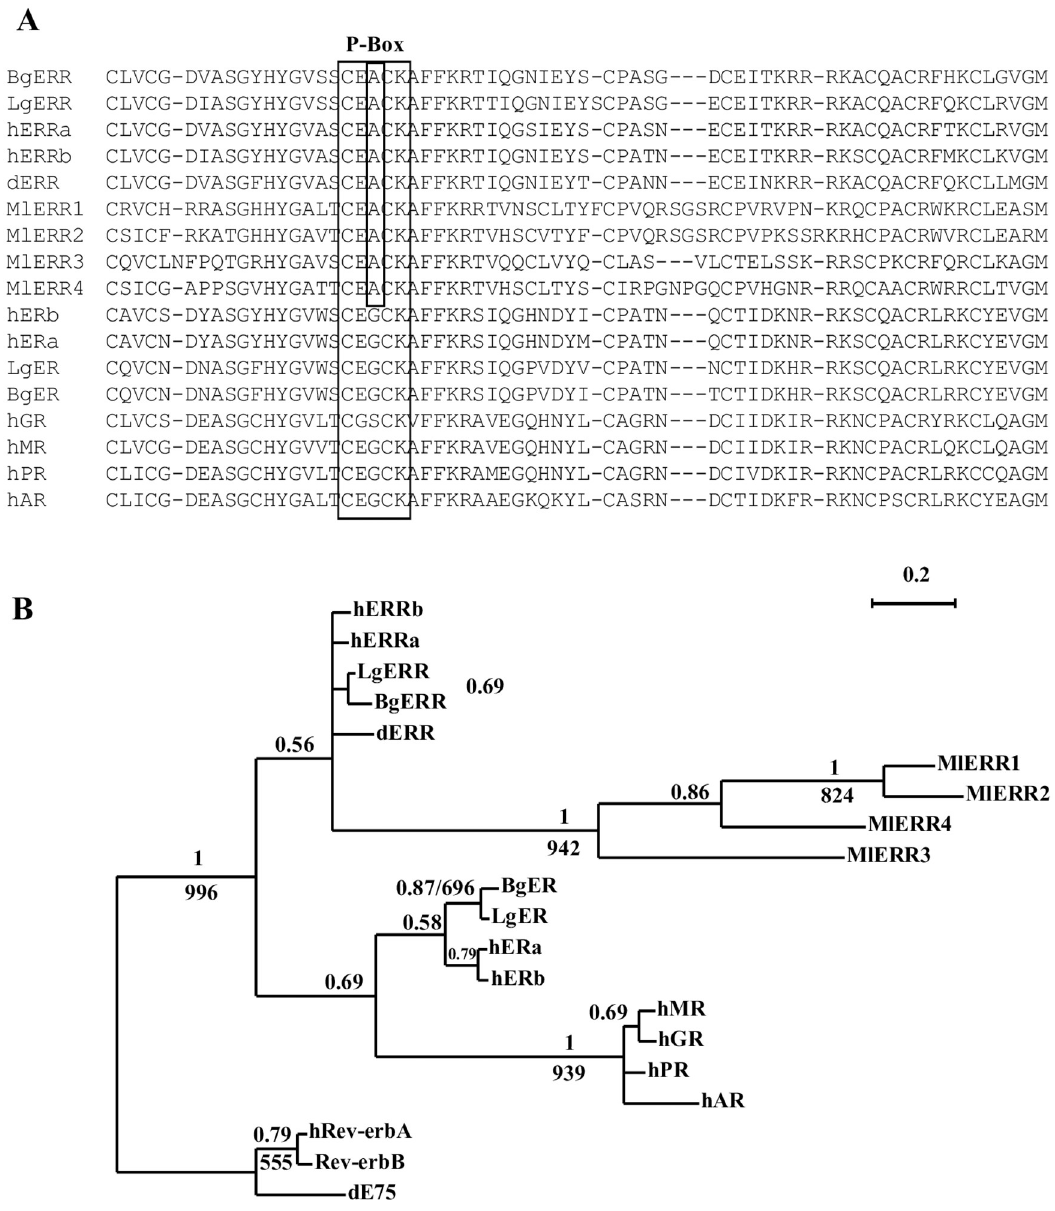
Fig 3. ERRs in Platyhelminths. A) Amino acid sequence alignment of DBD of MlERRs. B) Bayesian phylogenetic tree of MlERRs, the BPPs values are shown above each branch. Branches under the PPs 0.5 are shown as polytomies. The same data set was also tested by ML method using PHYML (v2.4.4) (under JTT +G model (equilibrium frequencies model, proportion of invariable sites was estimated as fixed 0.0, number of substitution rate categories: 4, gamma shape parameter was estimated as 0.547). Support values for the tree were obtained by bootstrapping a 1,000 replicates and bootstrap values above 500 are indicated below each branch (or after MrBAYES BPPs separated by Slash). Bg: Biomphalaria glabrata , d: Drosophila melanogaster , h: Homo sapiens , Lg: Lottia gigantean , Ml: Macrostomum lignano